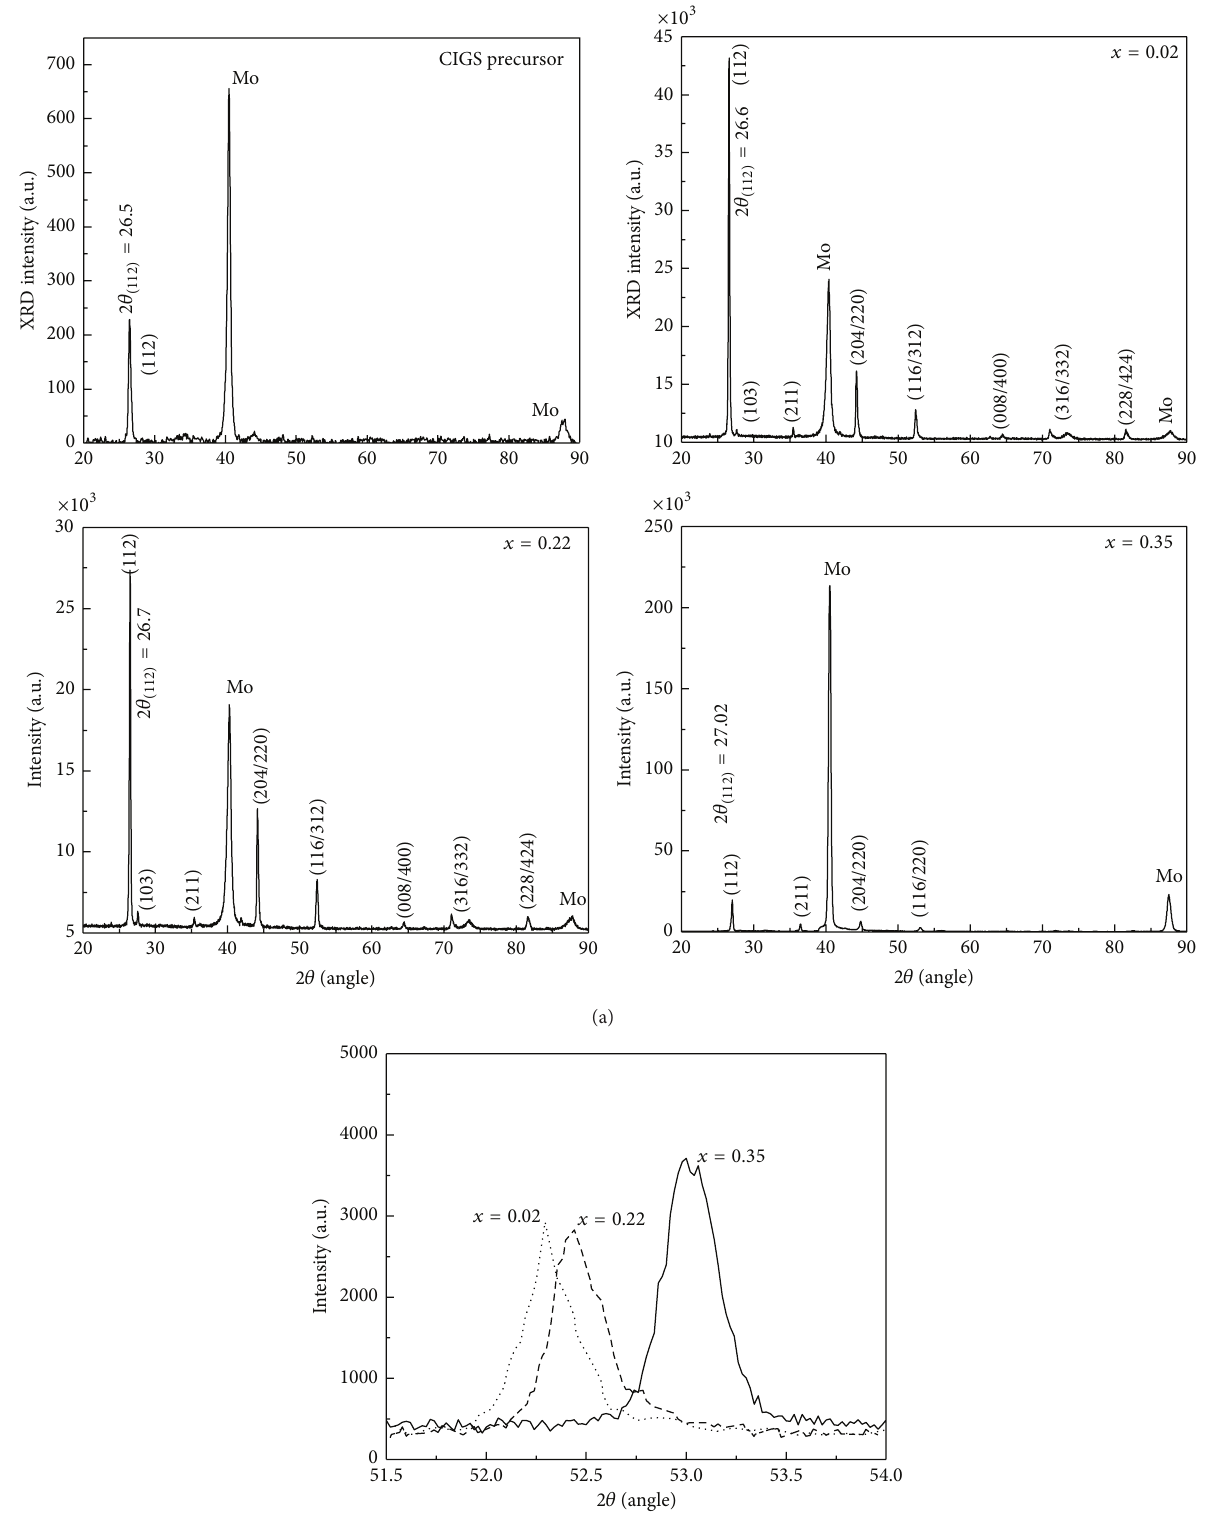
Figure 2: (a) XRD patterns of the precursor and CuIn 1− and 0.35). (b) Position of the [116/312] diffraction peaks of single-phase CuIn 1− and